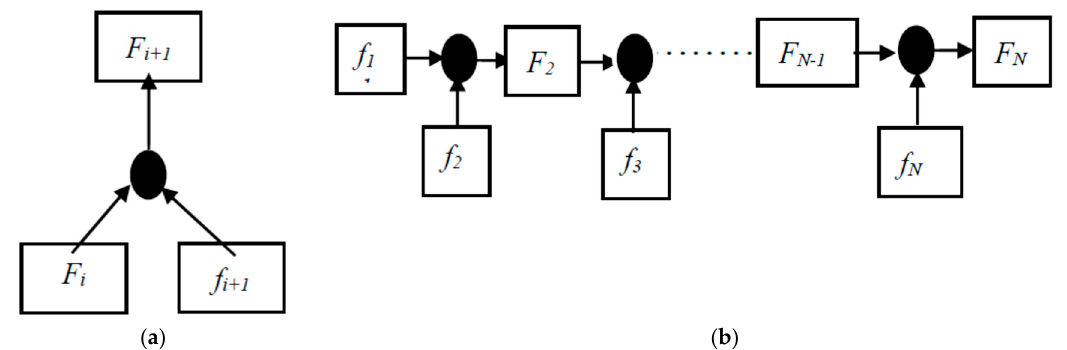
Figure 1. ( a , b ) Generation of our first and final Motion Map.